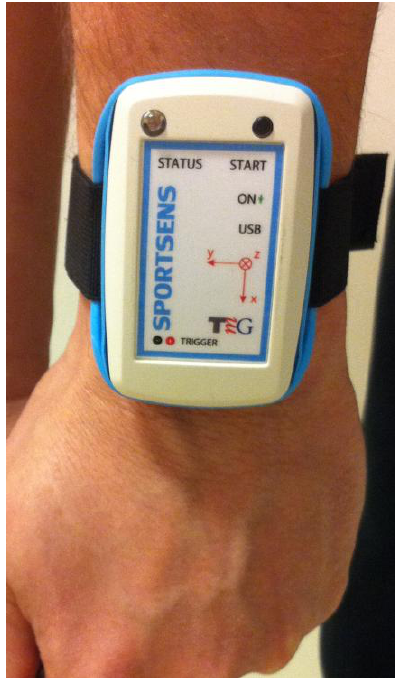
Figure 2. The specifically designed wearable 3D accelerometer and gyroscope motion sensor with its intrinsic coordinate system